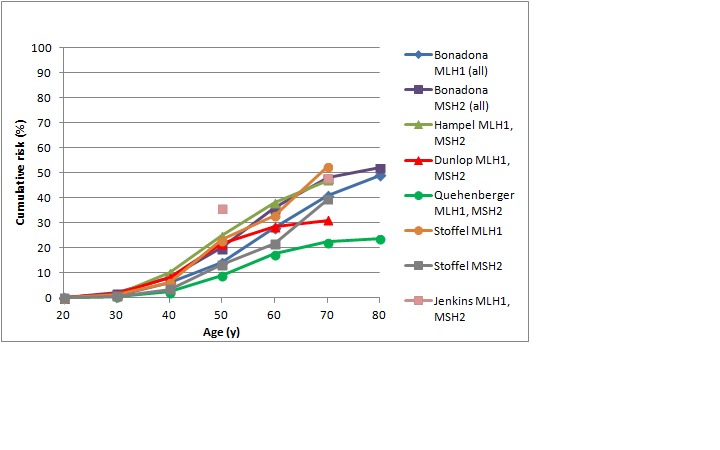
Studies shown: Bonadona,46 Hampel,42 Dunlop,43 Quehenberger,44 Stoffel,47 Jenkins45